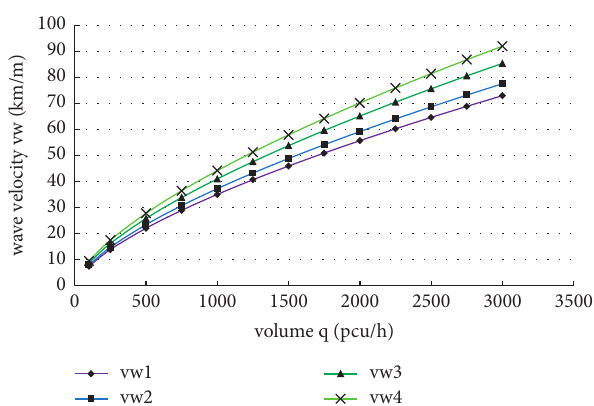
Figure 8: k � 125, relationship between critical wave velocity v j and flow q under the condition of different highway grades.